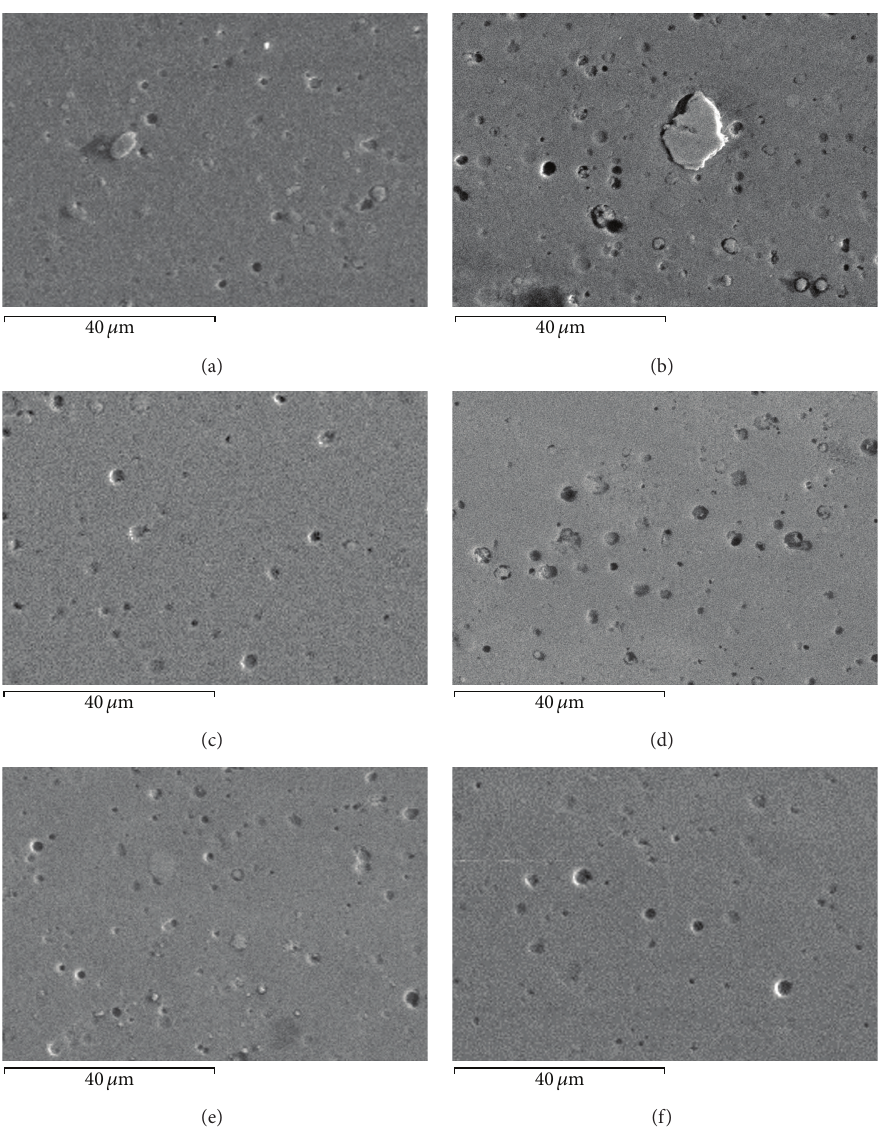
Figure 6: SEM images of the wear scare of samples CrN at 1, 5, and 9 N, respectively (a, b, c), and of samples CrN + MB at 1, 5, and 9 N, respectively (d, e, f). Sliding distance of